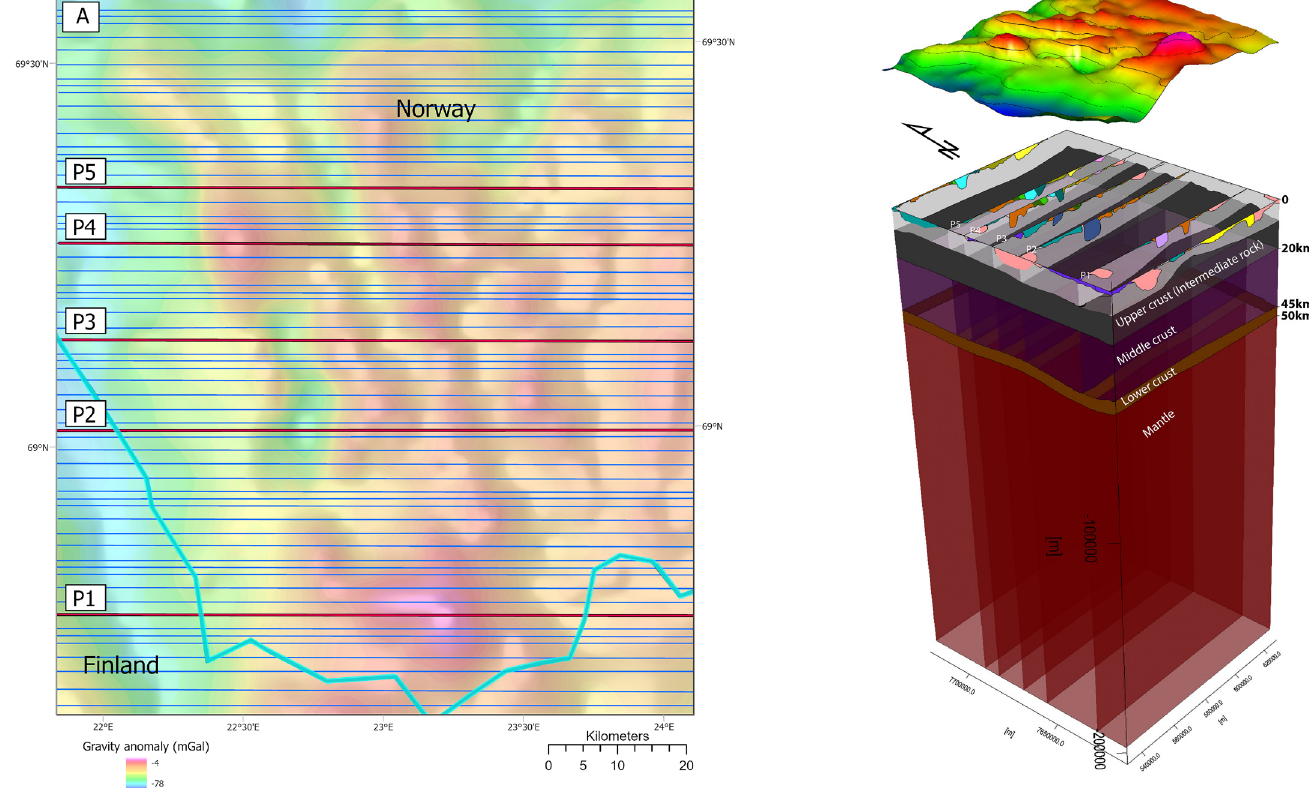
Figure 12. (A) Location of the 2D vertical slices through the 3D density model (blue lines). The red lines show the selected vertical slices discussed in the present paper (P1-P5). (B) 3D model of the area which shows the selected profiles with the numbers